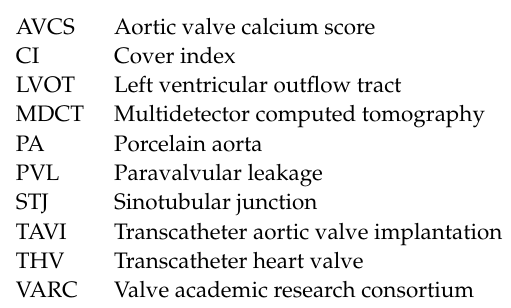
Table S3: Procedural outcomes and complications (entire population); Table S4: Matching Algorithm; Table S5: Technical